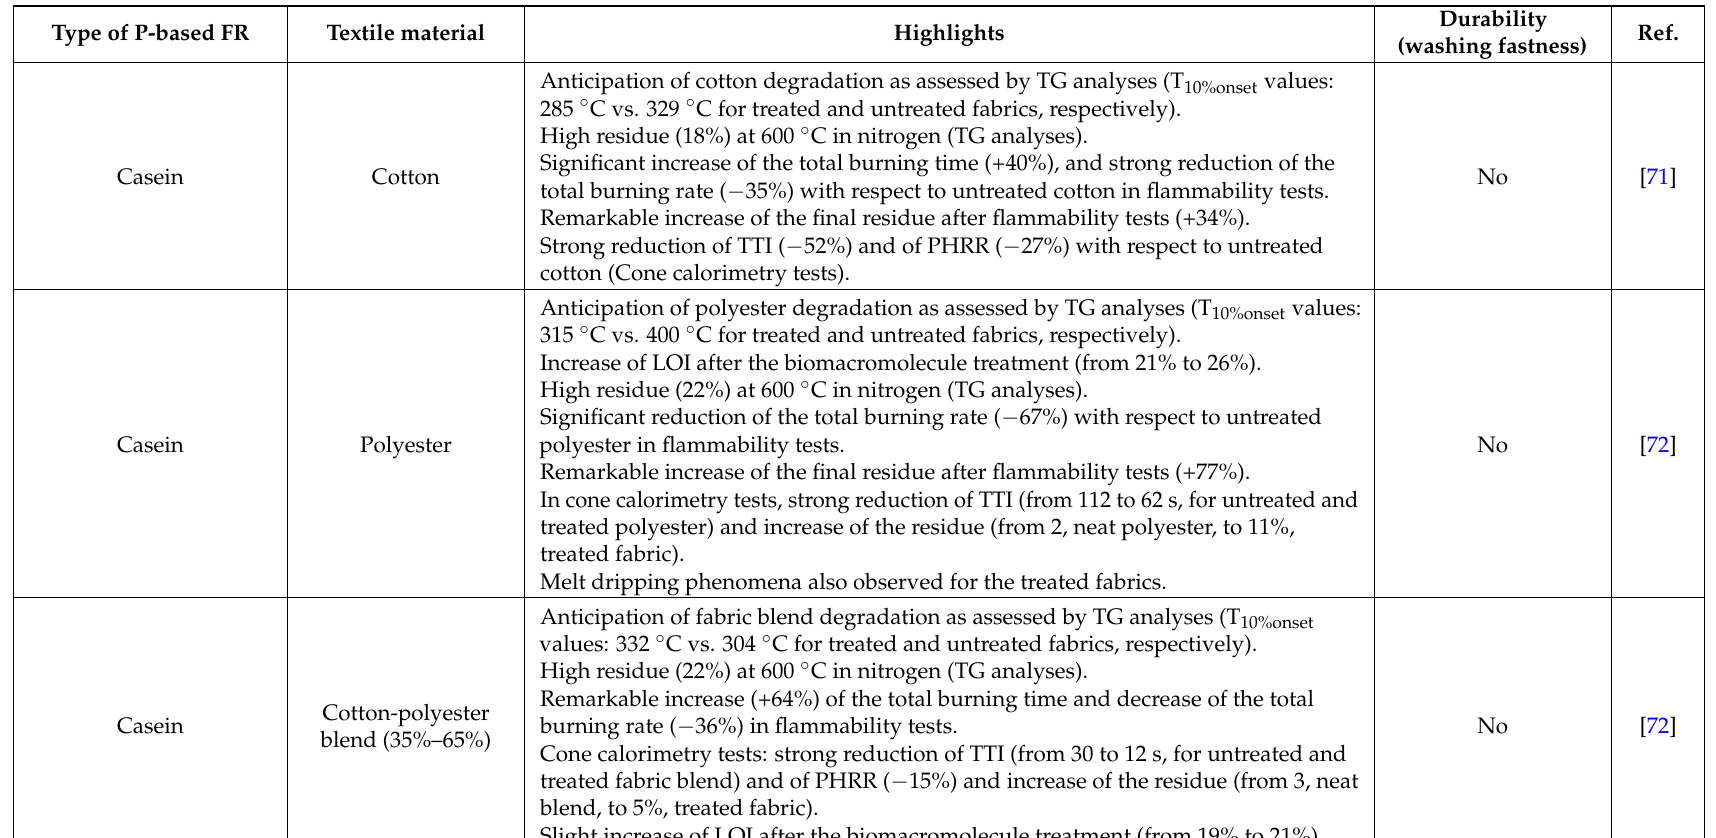
Table 3. Main results achieved by treating fabrics with biomacromolecules. Type of P-based